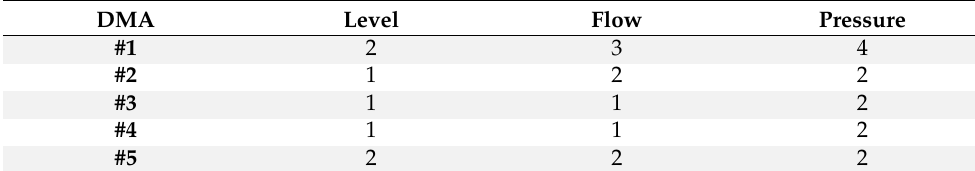
Figure 6. C-town WDS layout, DMAs by colored nodes, R1 is the water source, T1–T7 are the storage tanks, black triangles are pumps, gray triangles are valves, and pipe diameter is illustrated by the line thickness. Table 1. Sensor type and count in the C-town case